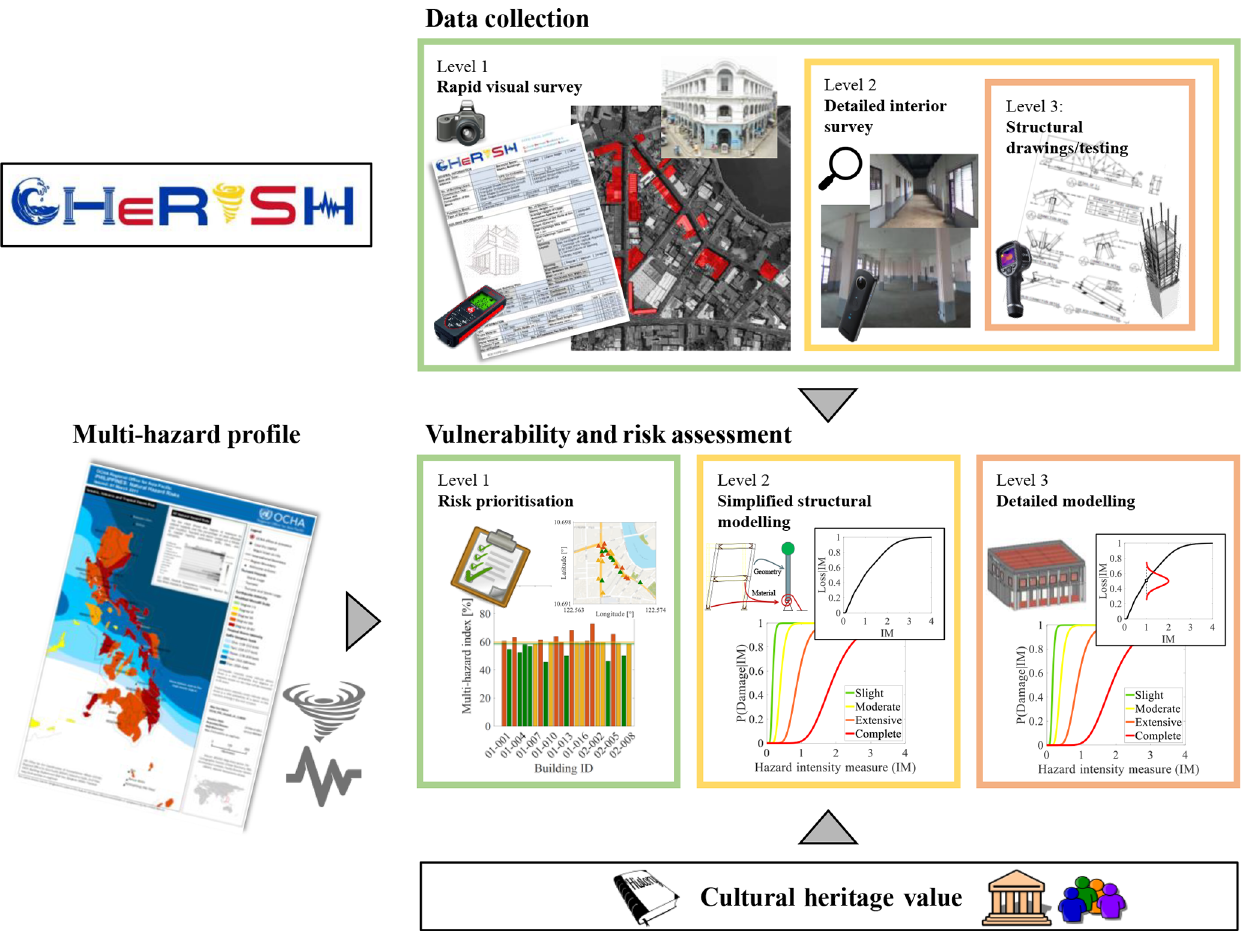
Figure 1. CHeRiSH multilevel, multi-hazard risk assessment